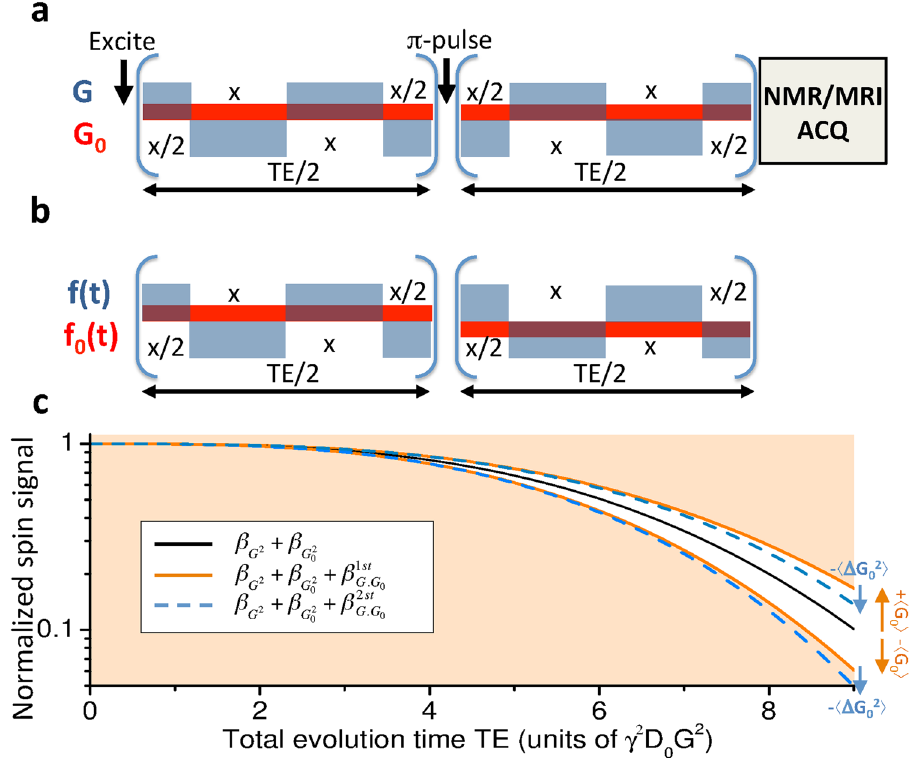
Figure 1. Defining and measuring the effects of susceptibility-induced gradients-distribution tensors by magnetic resonance. ( a , b ) Sequence involving an initial spin excitation, a square-wave gradient modulation G ( t ) (blue boxes), and an echoed background gradient modulation G 0 ( t ) (in red in panels a and b) deriving from a spin-echo sequence involving a π -pulse. Panel (b) expresses the sequence’s modulations in terms of square-wave functions, and the delay x = TE / N in this particular example is assumed to be N = 6. NMR/MRI acquisitions are performed at the end of the sequence. ( c ) Normalized spin signal expected as a function of the total evolution time TE , describing the overall diffusion-driven attenuation in terms of different factors β ( TE ) that relate to first- and second-order descriptions of the background gradient distribution G 0 , and of an externally applied gradient G (see text). The different signs reflect the attenuations expected when G acts parallel or antiparallel to the background gradient’s direction. All plots